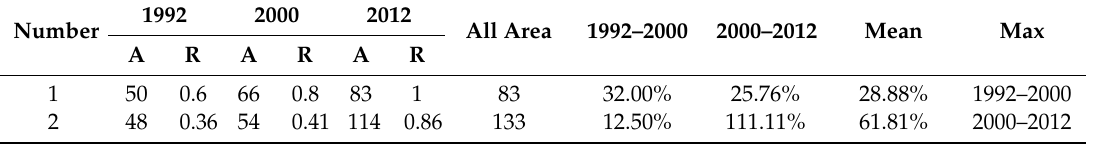
Table 7. Statistics of the built-up areas within the economic corridor for